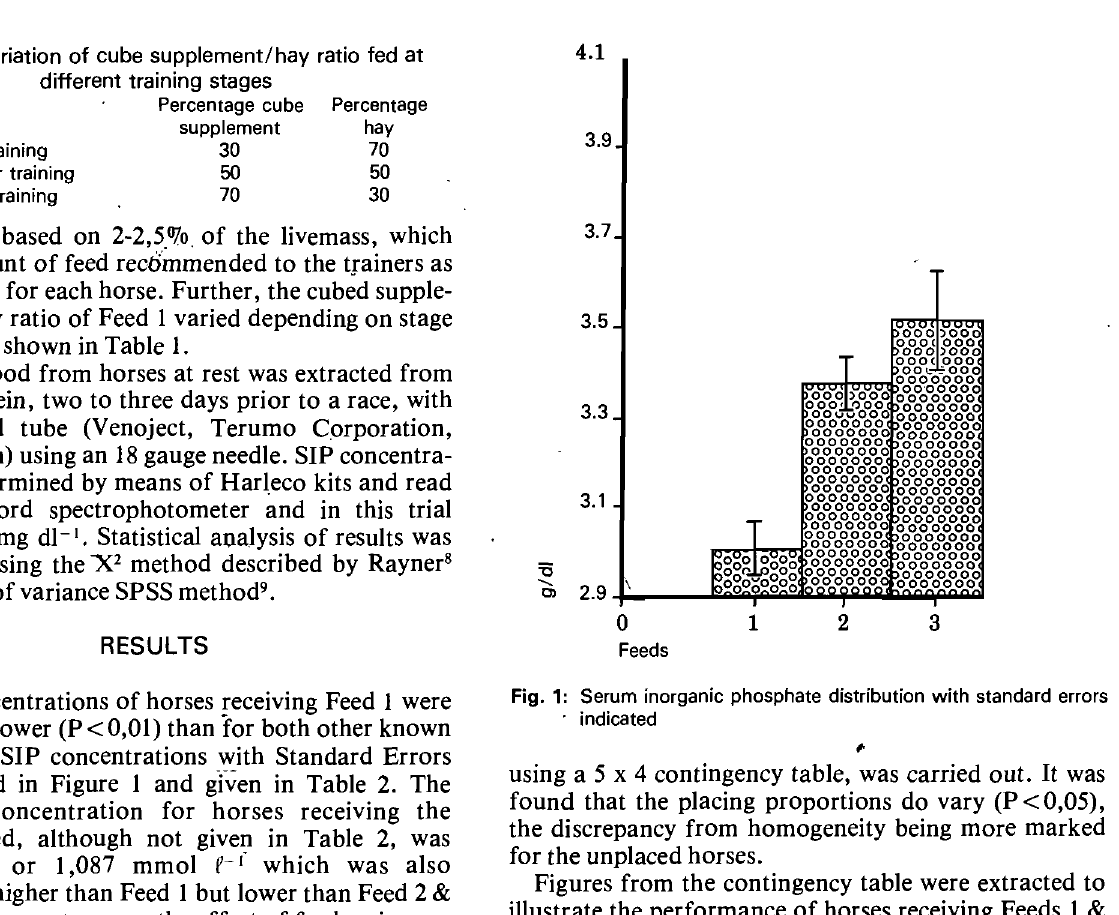
Table 2: Mean serum SIP concentrations from horses on Feed